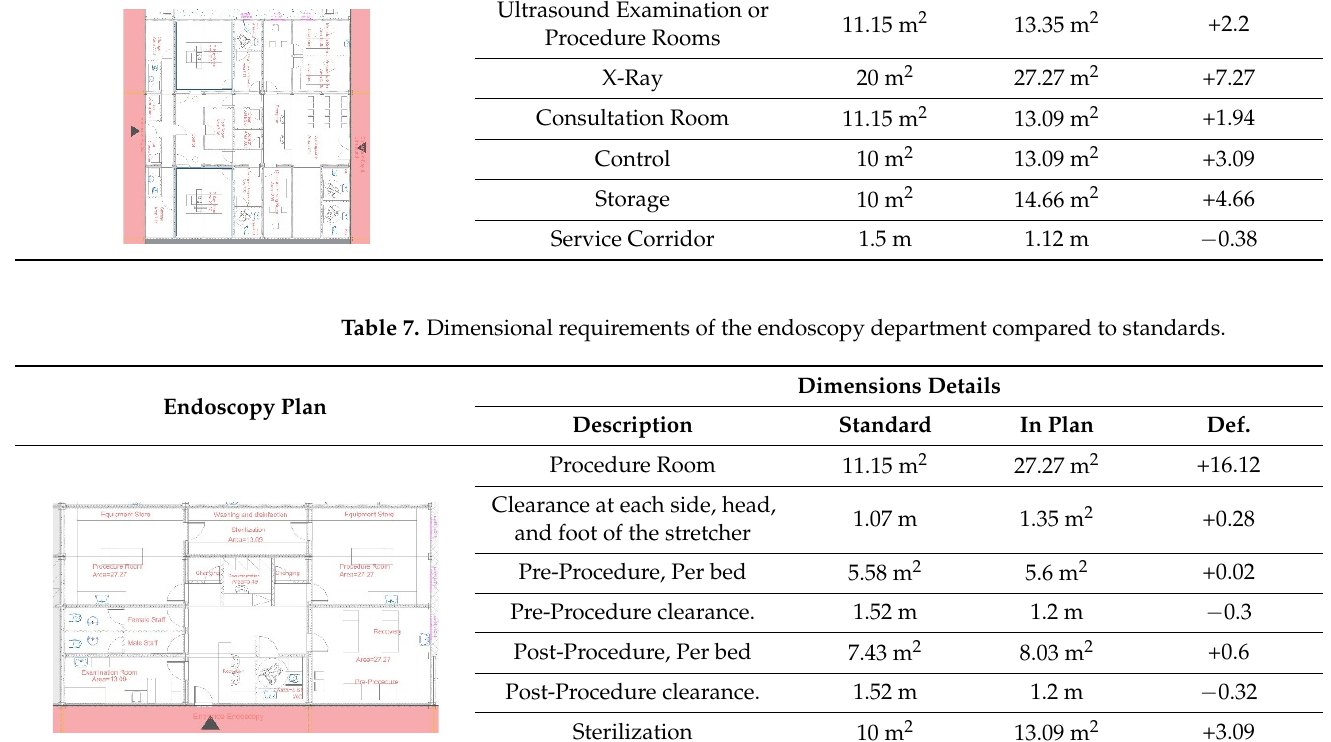
Table 7. Dimensional requirements of the endoscopy department compared to standards.